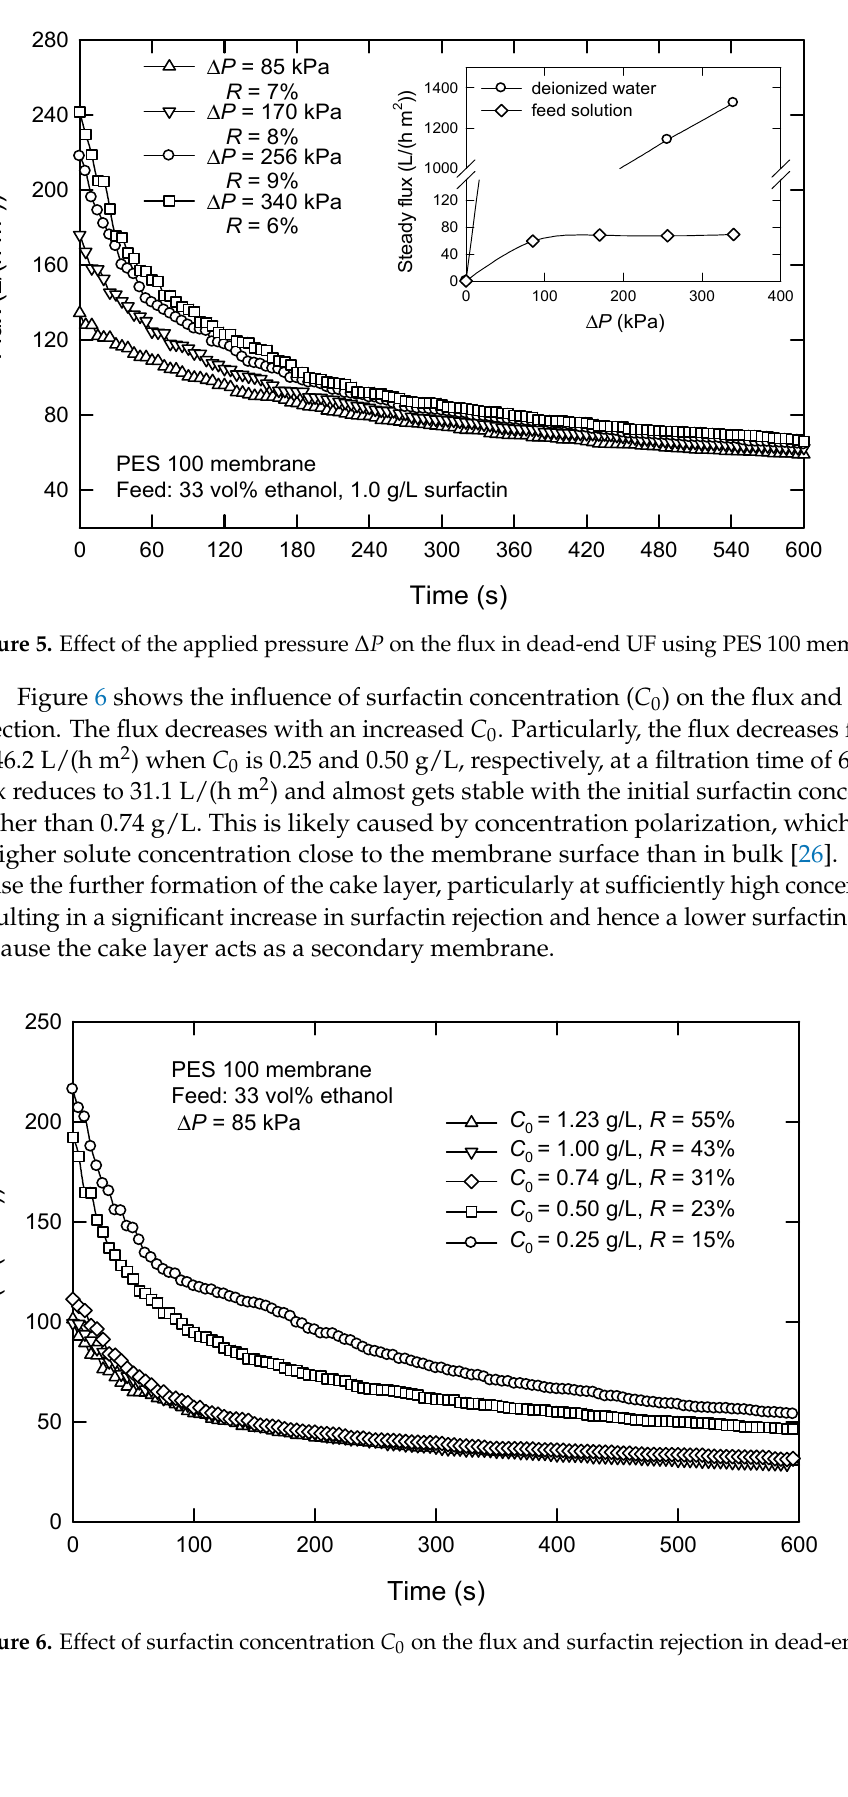
peptides, and proteins, on the membrane surface [25]. Thus, an applied pressure of 85 kPa was chosen in dead-end UF.